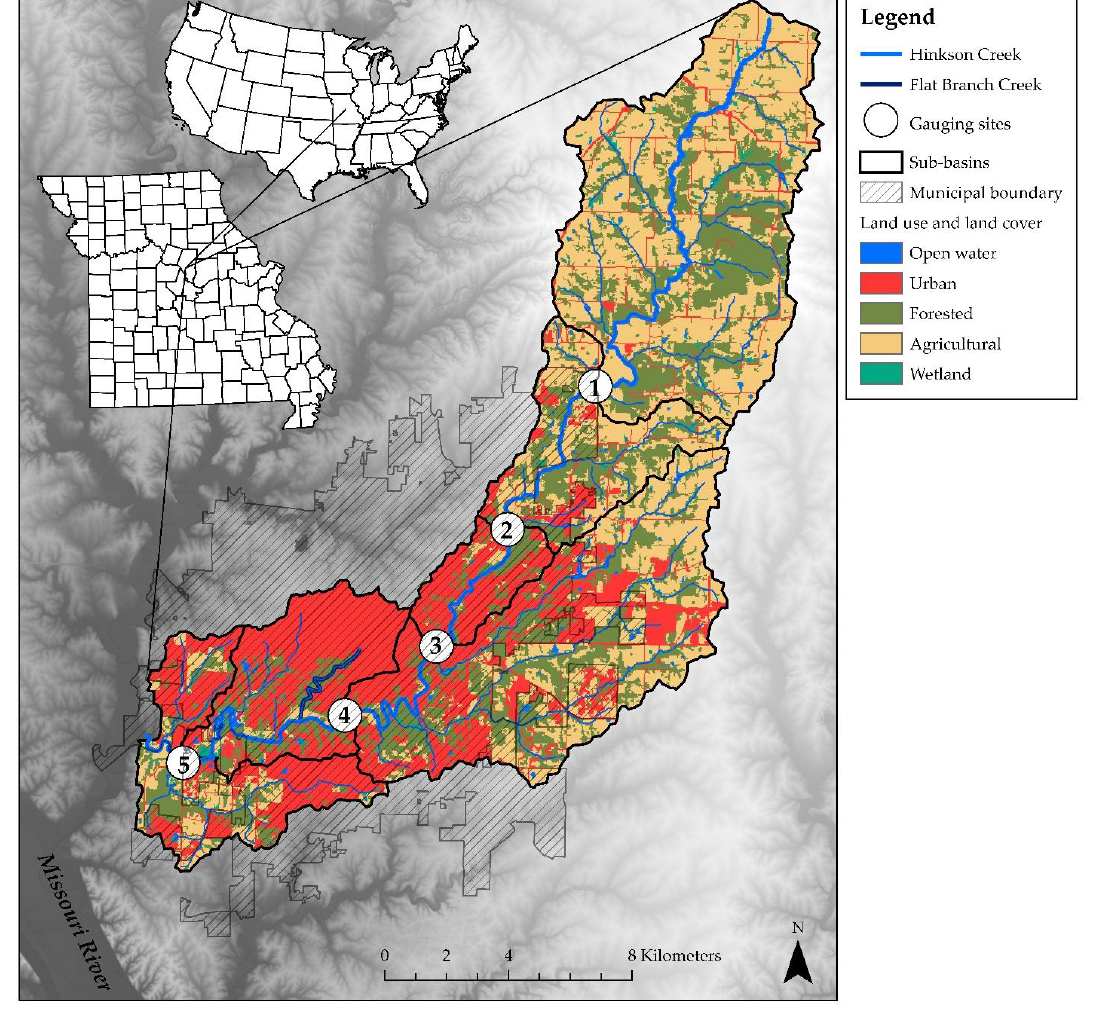
Figure 1. Land use and land cover of Hinkson Creek Watershed, Missouri, USA. Five nested gauging sites (numbered 1 to 5) and corresponding sub-basins are shown. Site #5 was located near the watershed outlet, Sites #1 to #4 nested within.